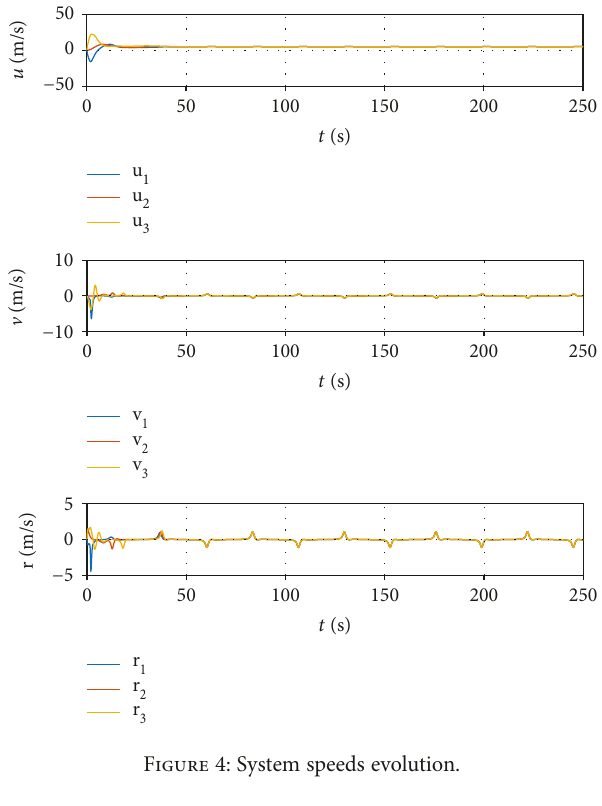
Figure 2: Topology of three UUVs with the reference information only being available to vehicle 1.